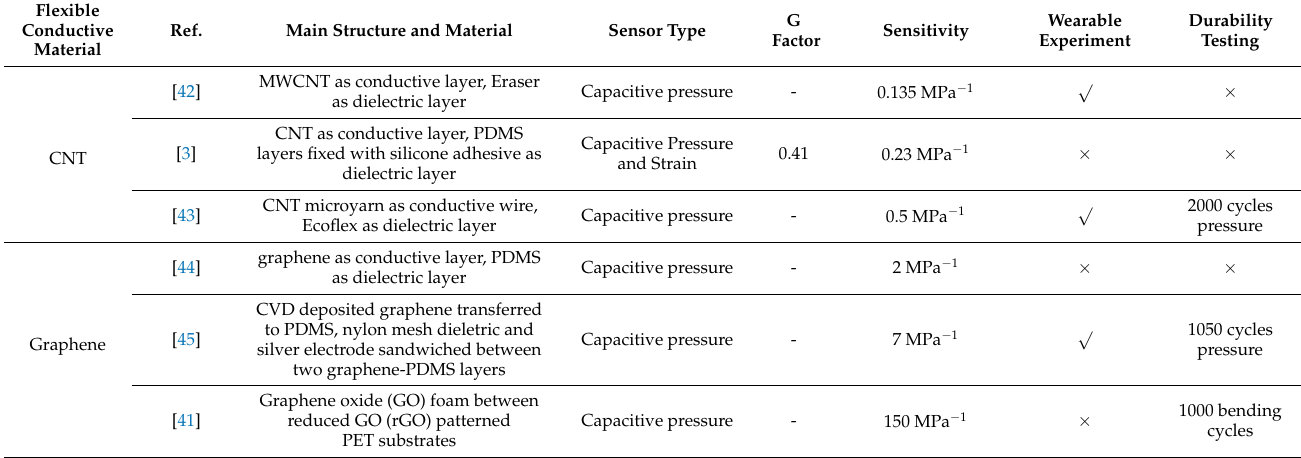
Table 1. Summary of performance of flexible capacitive strain and pressure sensors, reported in the literature, which do not possess a porous silicone dielectric material. Sensors were evaluated over five aspects: fabrication process, capacitive gauge factor (GF) for strain sensors, sensitivity over the 10 kPa range for pressure sensors, characterization as a wearable sensor, and character- ization of sensor durability. Abbreviations: MWCNT—multi-walled carbon nanotube; CNT—carbon nanotube, CVD—chemical vapor deposition; SBS—poly(styrene-block-butadien-styrene); AgNP—silver nanoparticle; AgNW—silver nanowire. Flexible Conductive Material